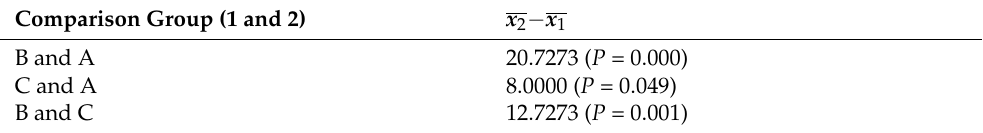
Table 3. Multiple comparison results of three menu styles based on the Bonferroni method.